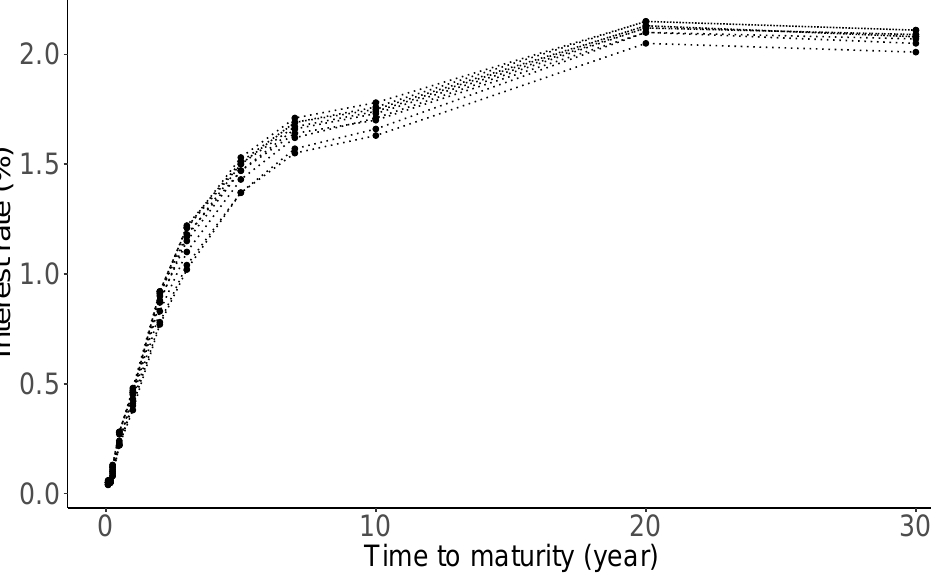
Figure 5. Daily Treasury par yield curve rates from 3 to 13 January